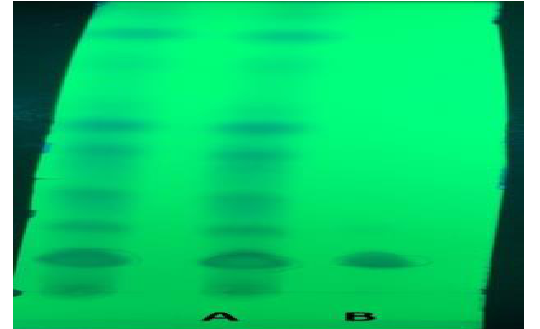
Figure 4. HPTLC for hexane fraction, A: Beta- sitosterol (standard), B: Stigma-sterol, C: Hexane fraction, mobile phase: Hexane: ethyl acetate (50: 50). B- HPTLC was carried on ethyl acetate fraction using mobile phase: Ethyl acetate: formic acid: acetic acid: water (84:4:4:10) and revealed the presence of rutin as compared the retardation factor (RF) with standard of rutin as shown in figures 5-7.